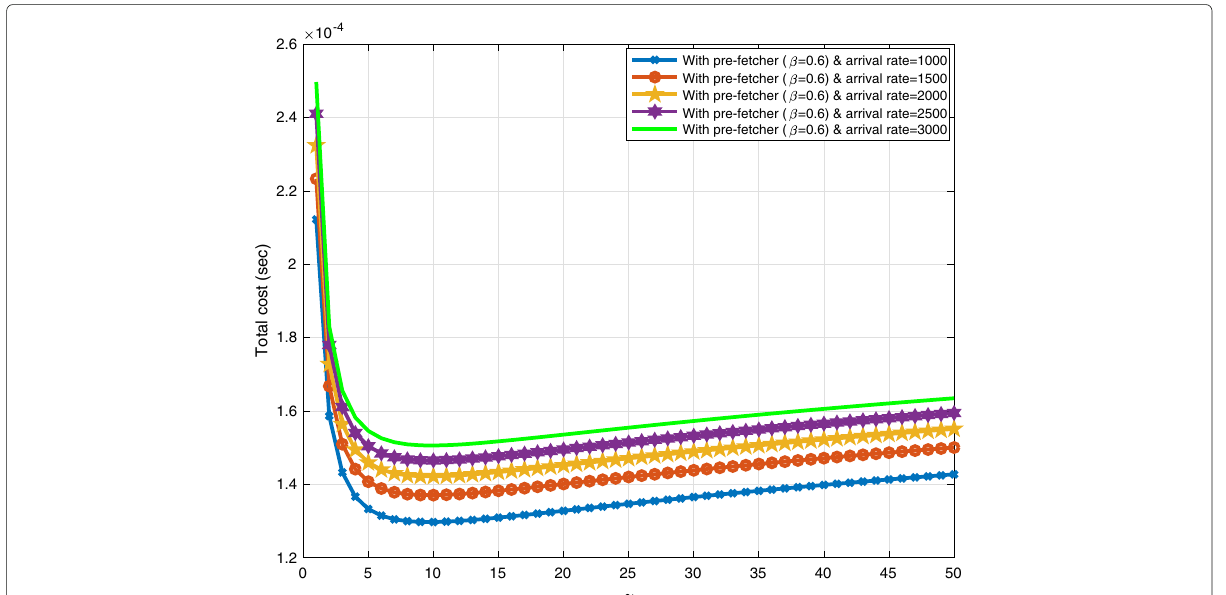
Fig. 8 Impact of increasing arrival rate and γ on Total cost when β = 0.6. With pre-fetcher ( β = 0.6) and arrival rate=1000, With pre-fetcher ( β = 0.6) and arrival rate=1500, With pre-fetcher ( β = 0.6) and arrival rate=2000, With pre-fetcher ( β = 0.6) and arrival rate=2500, With pre-fetcher ( β = 0.6) and arrival rate=3000,